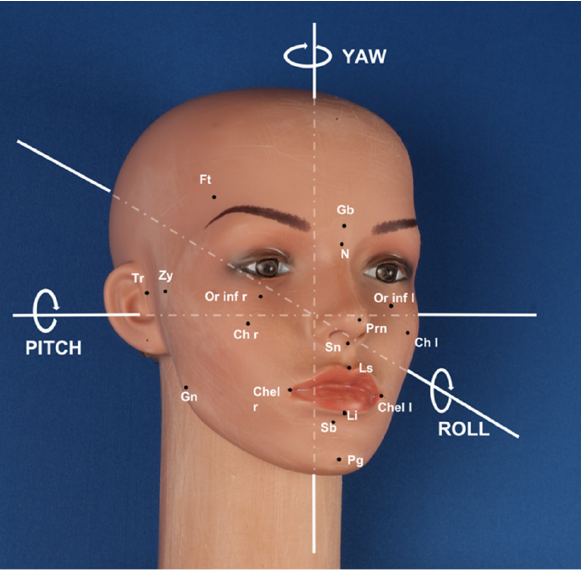
Figure 1. Dummy: anthropometric points and illustration of movements. A three-quarter represen- tation of the mannequin’s head with anthropometric points marked in black. Additionally, the pitch, roll, and yaw movements are expressed with white lines and arrows that simulate the movement.